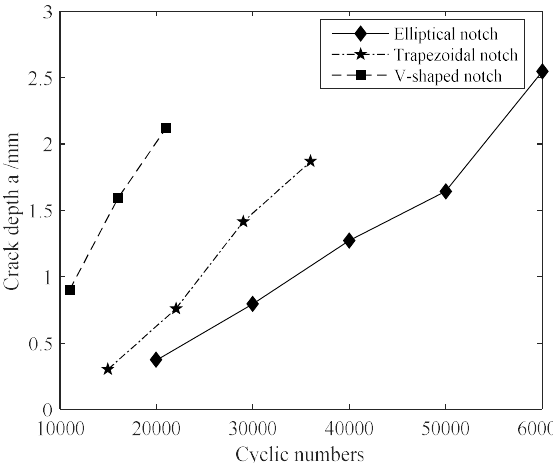
Figure 26. Variation of crack depth with cyclic numbers. Table 8. Coefficient table.